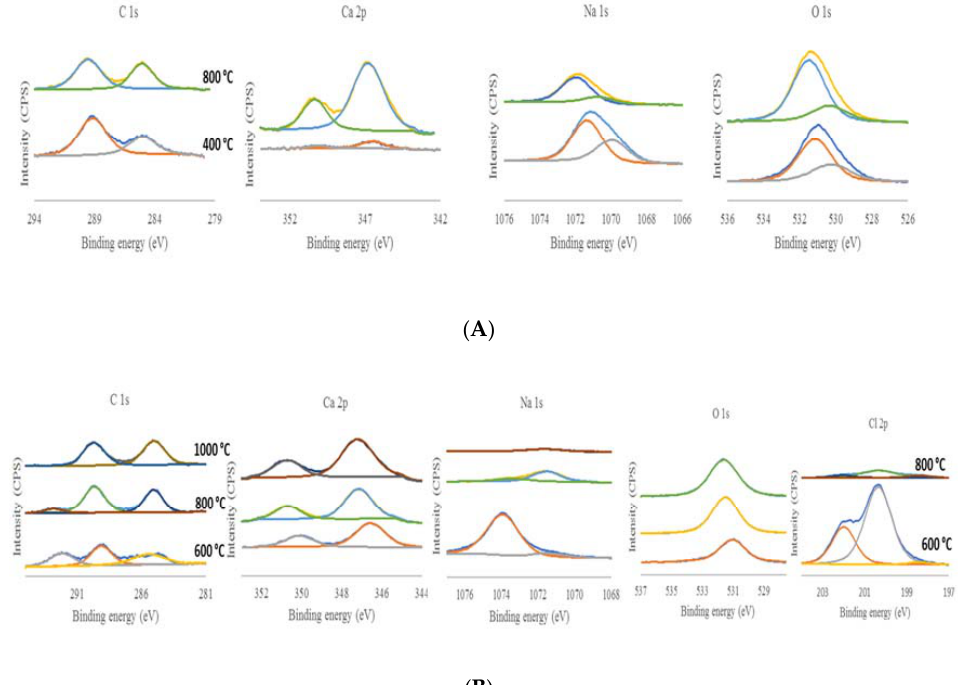
Figure 5. The elemental XPS peaks were deconvoluted for ( A ) NaOH supported oyster shell (NaOH 6 /Shell-400 (bottom) and NaOH 6 /Shell-800 (top) and ( B ) NaCl/Oyster shell (NaCl 2.43 /Shell-600 (bottom), NaCl 2.43 /Shell-800 (middle) and NaCl 2.43 /Shell-1000 (top). For Cl 2p, NaCl 2.43 /Shell-600 (bottom) and NaCl 2.43 /Shell ‐ 800 (top)).